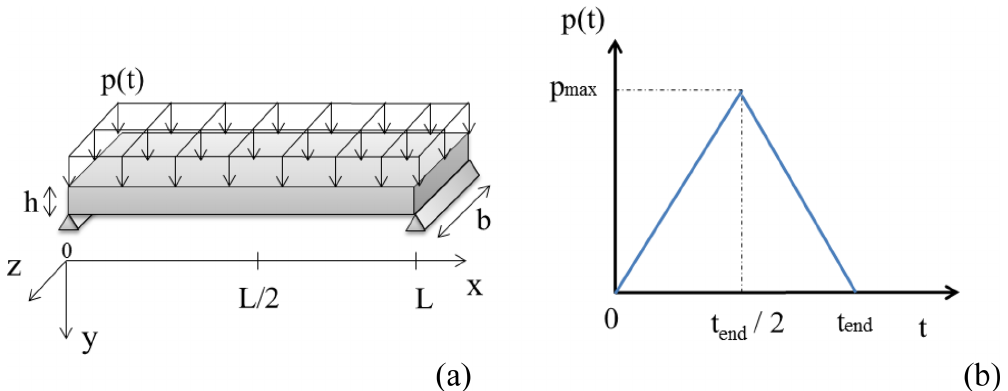
Figure 1. Simply supported RC wall loaded by a uniform pressure field (a) and time evolution of the applied pressure based on triangular shape (b) . The maximal pressure ( p max ) is reached for time t = t end / 2 where t end corresponds to the end of the pressure application.